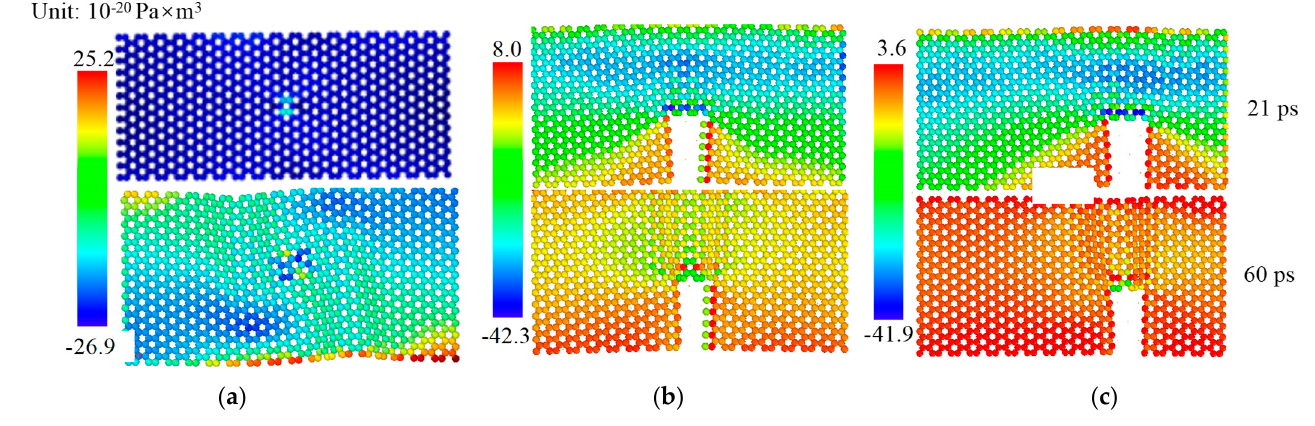
Figure 13. Stress changes of h-BN flakes with the simulation time: ( a ) Stress change of the intact model with time. ( b ) Stress change of the model with a crack in the middle region with time. ( c ) Stress change of the model with a crack in the side region with time.